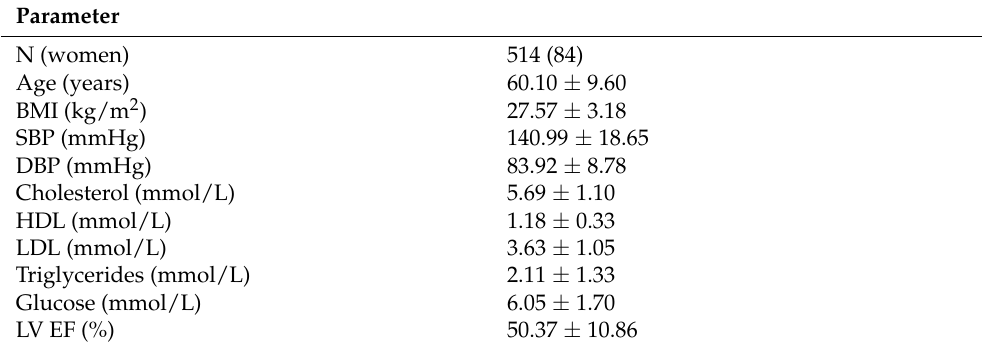
Table 1. Study groups